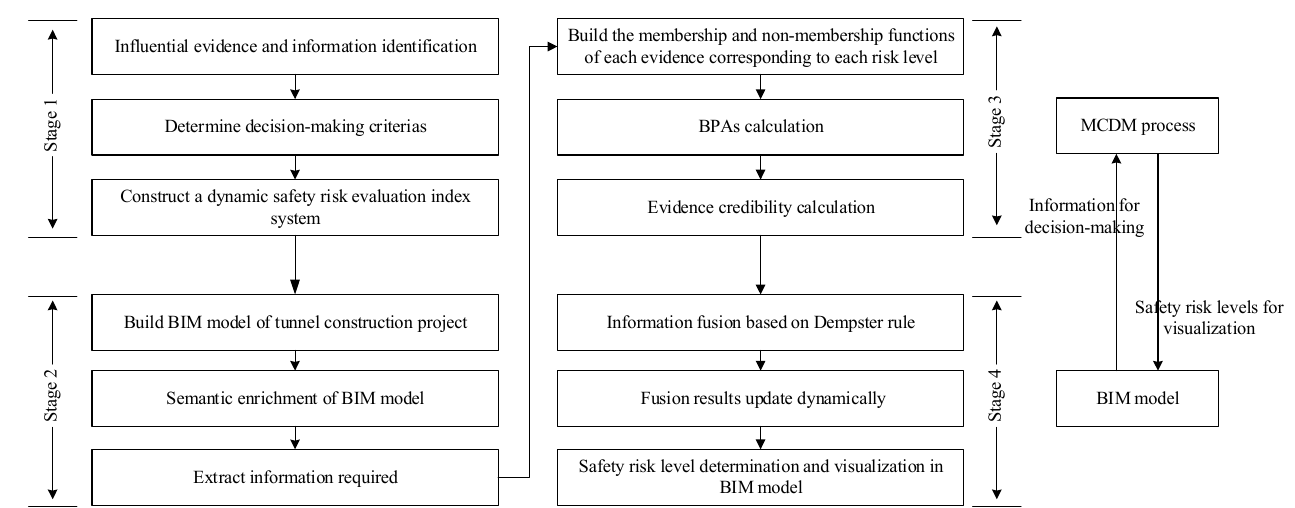
Figure 1. The flow chart of the proposed safety risk assessment method.